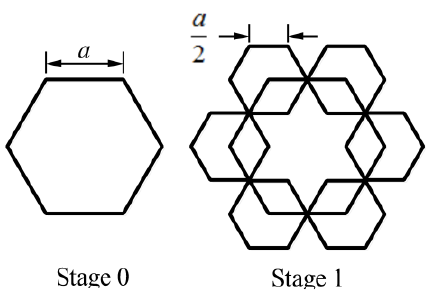
Figure 2: Iterations of the proposed Fractal antenna. corresponds to a characteristic impedance of 50 Ω, and gap g=0.4 mm. The design of the antenna starts with a hexagon- shaped microstrip patch antenna, as shown in Figure 2.